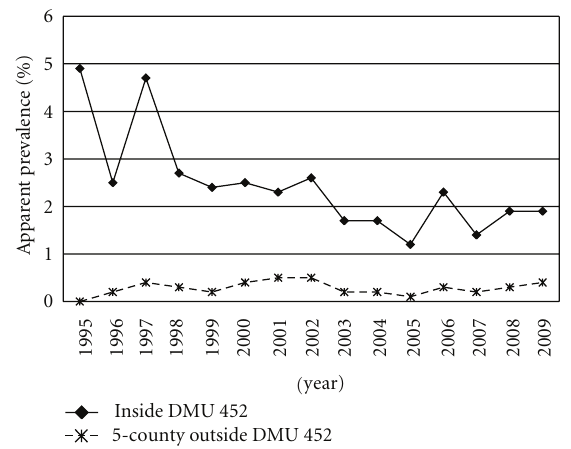
Figure 6: Sample prevalence of BTB in Michigan wild white-tailed